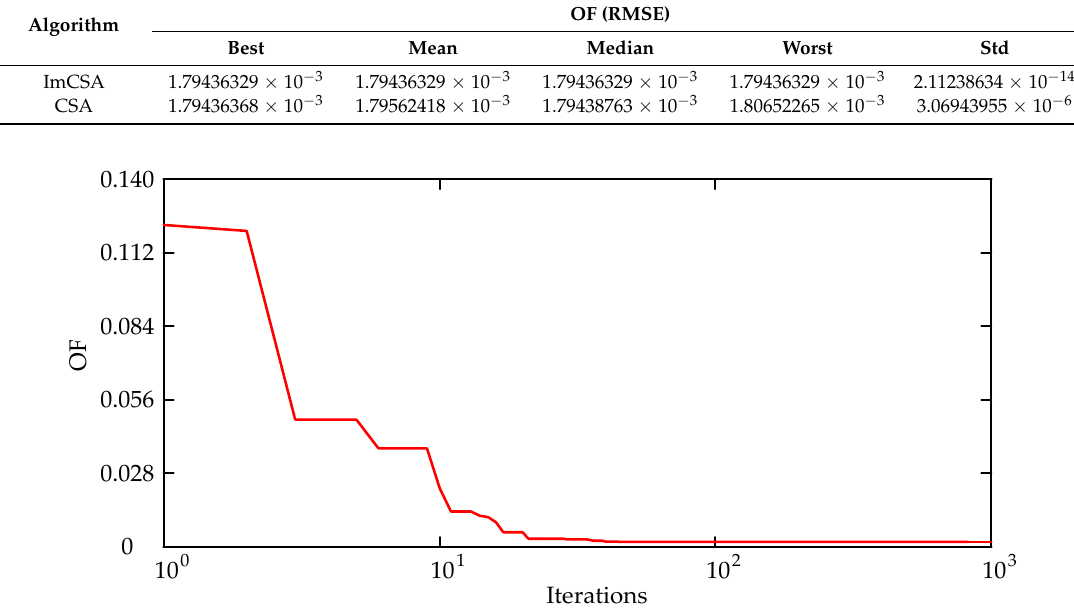
Figure 12. Convergence characteristic of the proposed ImCSA for parameter estimation of the PMM of monocrystalline STM6-40/36 panel. Table 14. Comparison among various parameter estimation algorithms for the PMM of monocrystalline STM6-40/36 panel.